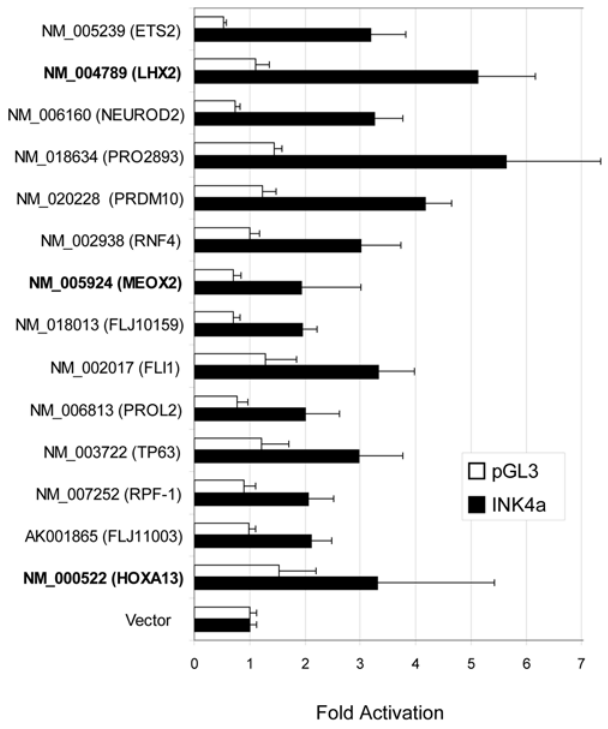
Figure 2. Confirmation of 14 INK4a activators. Results from four independent cotranfections of the indicated reporter with the indicated cDNA construct into U2OS cells are shown. Fold activation values were calculated for each experiment by normalizing luciferase levels of the indicated cDNA to the empty vector control (indicated as Vector). These values were then ranked by ratio of activation of the INK4a construct to activation of the empty luciferase reporter vector pGL3. Activators with relative activation values of two or more are shown. Homeodomain family members are in bold; error bars represent one standard